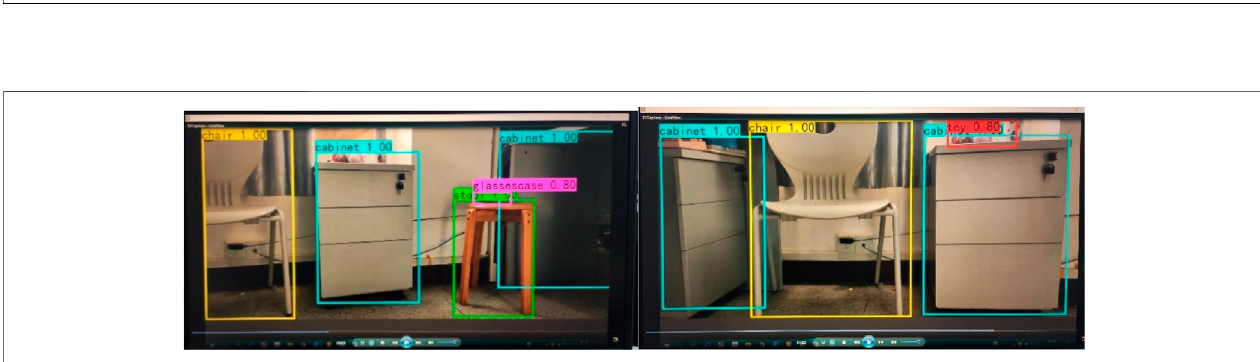
FIGURE 11 | Detection effect of real-time detection model on video.